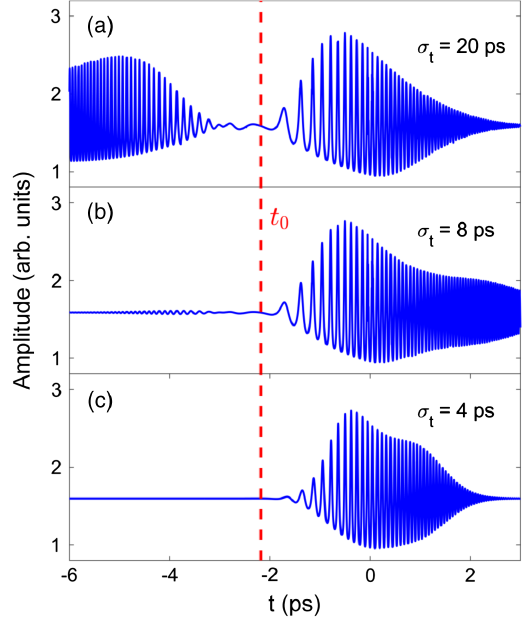
FIG. 4. Final beam density distribution for different laser pulse lengths. (a) σ t ¼ 20 ps; (b) σ t ¼ 8 ps; and (c) σ t ¼ 4 ps. The red dotted line is the symmetrical axis t 0 . The head of the beam is on the right